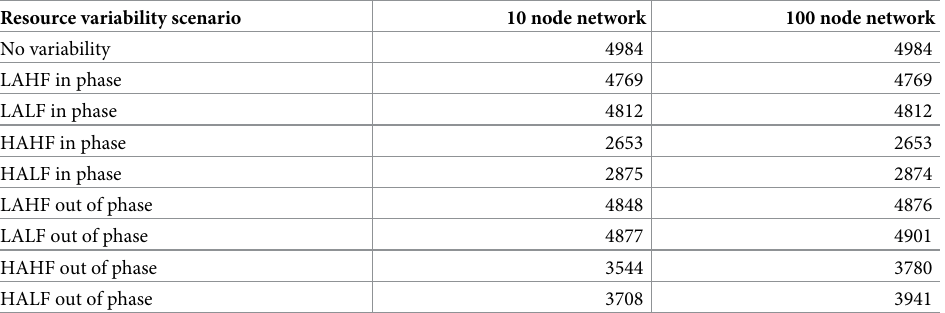
Table 2. The Global Equilibrium Population (GEP, the average population of the nodes in the networks after equi- librium) of the 10 and 100 node networks under the different resource variability scenarios: Low amplitude high frequency (LAHF), low amplitude low frequency (LALF), high amplitude high frequency (HAHF) and high ampli- tude low frequency (HALF). GEP is higher under out of phase variability and within the variability scenarios higher under lower amplitude and lower frequency of variability.